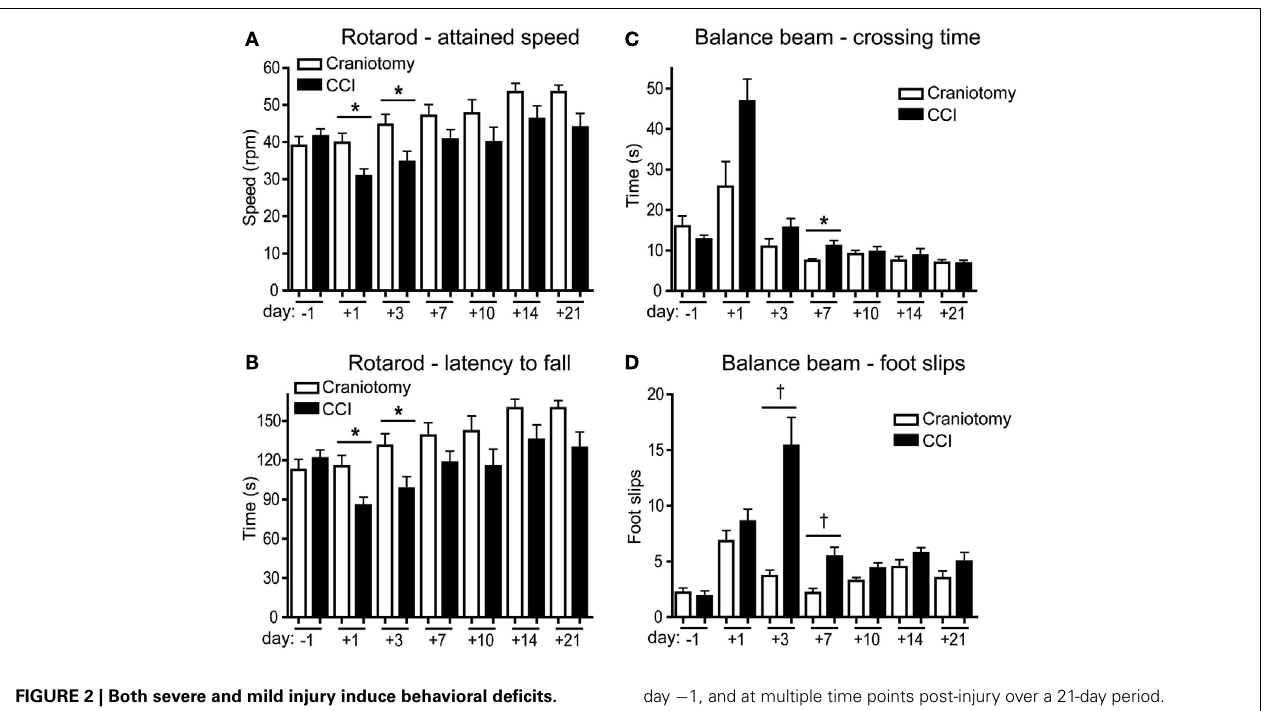
FIGURE 2 | Both severe and mild injury induce behavioral deficits. (A,B) Rotarod assay ( n = 12). Mice were assessed to determine the maximum speed attained (A) and the latency to fall (B) during execution of the accelerating rotarod task (B) . (C,D) Balance beam assay. Mice were assessed for latency to cross the beam (C) and the number of foot slips during the cross (D) . All tests were performed at